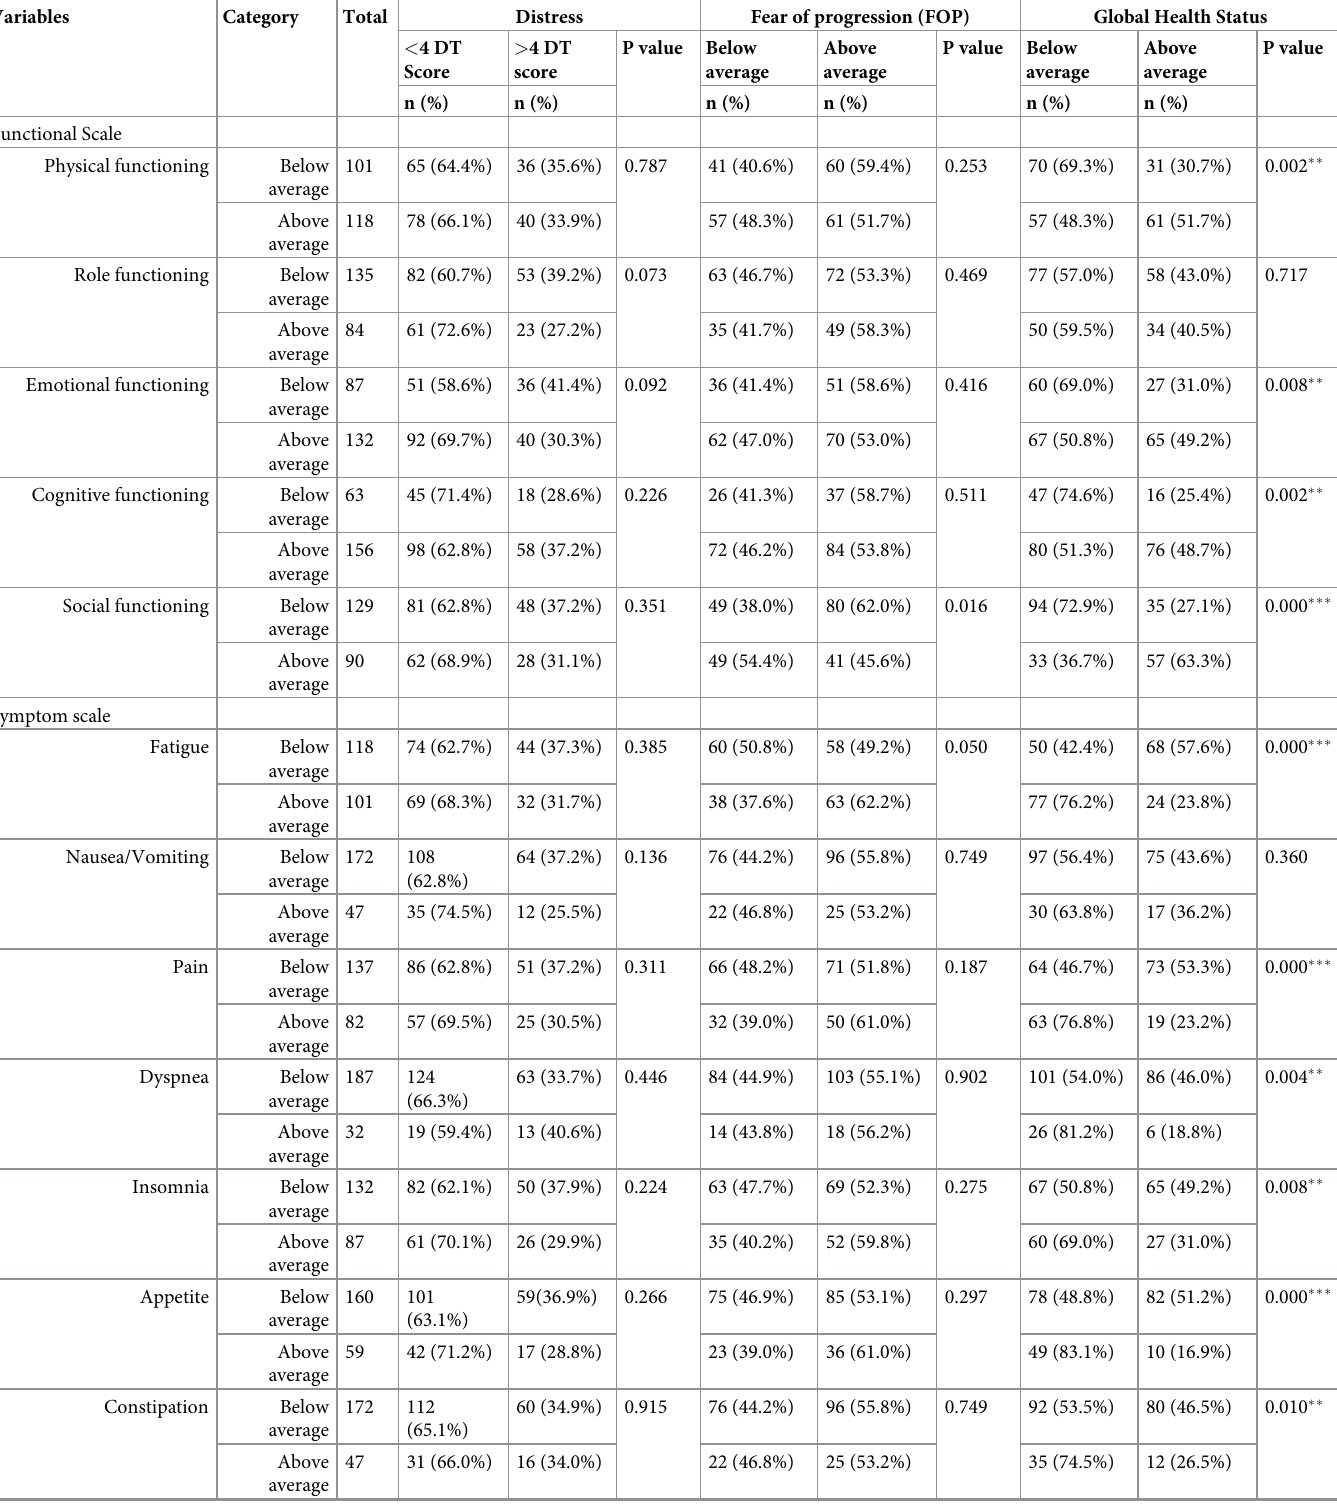
Table 3. Association of psychosocial concerns and issues of study participants (n = 219) with distress, FOP and global health status during COVID-19